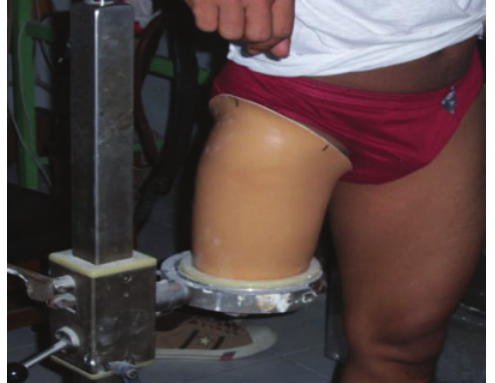
Figure 12: Static comfort test of socket prosthesis